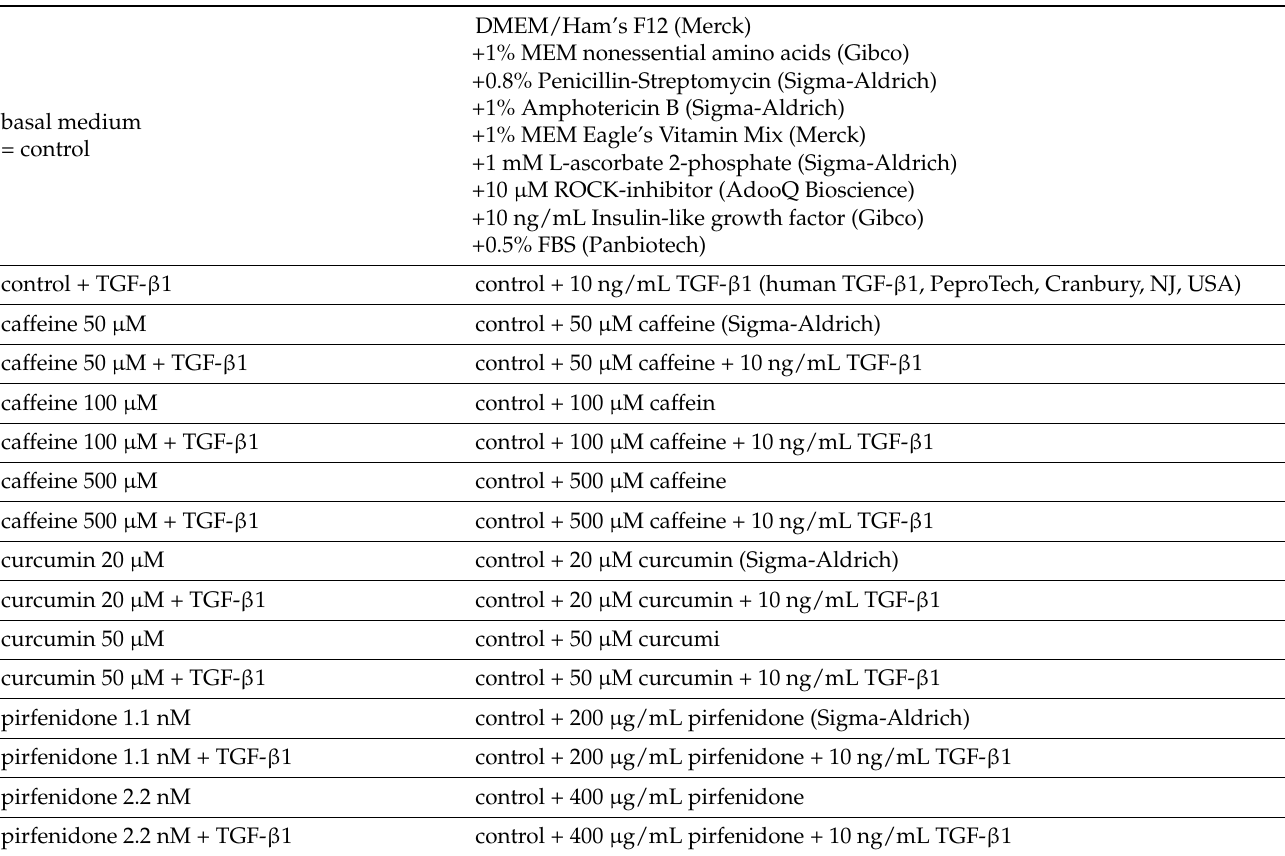
Table 2. Medium composition for testing the effects of the antifibrotic molecules (AFM)